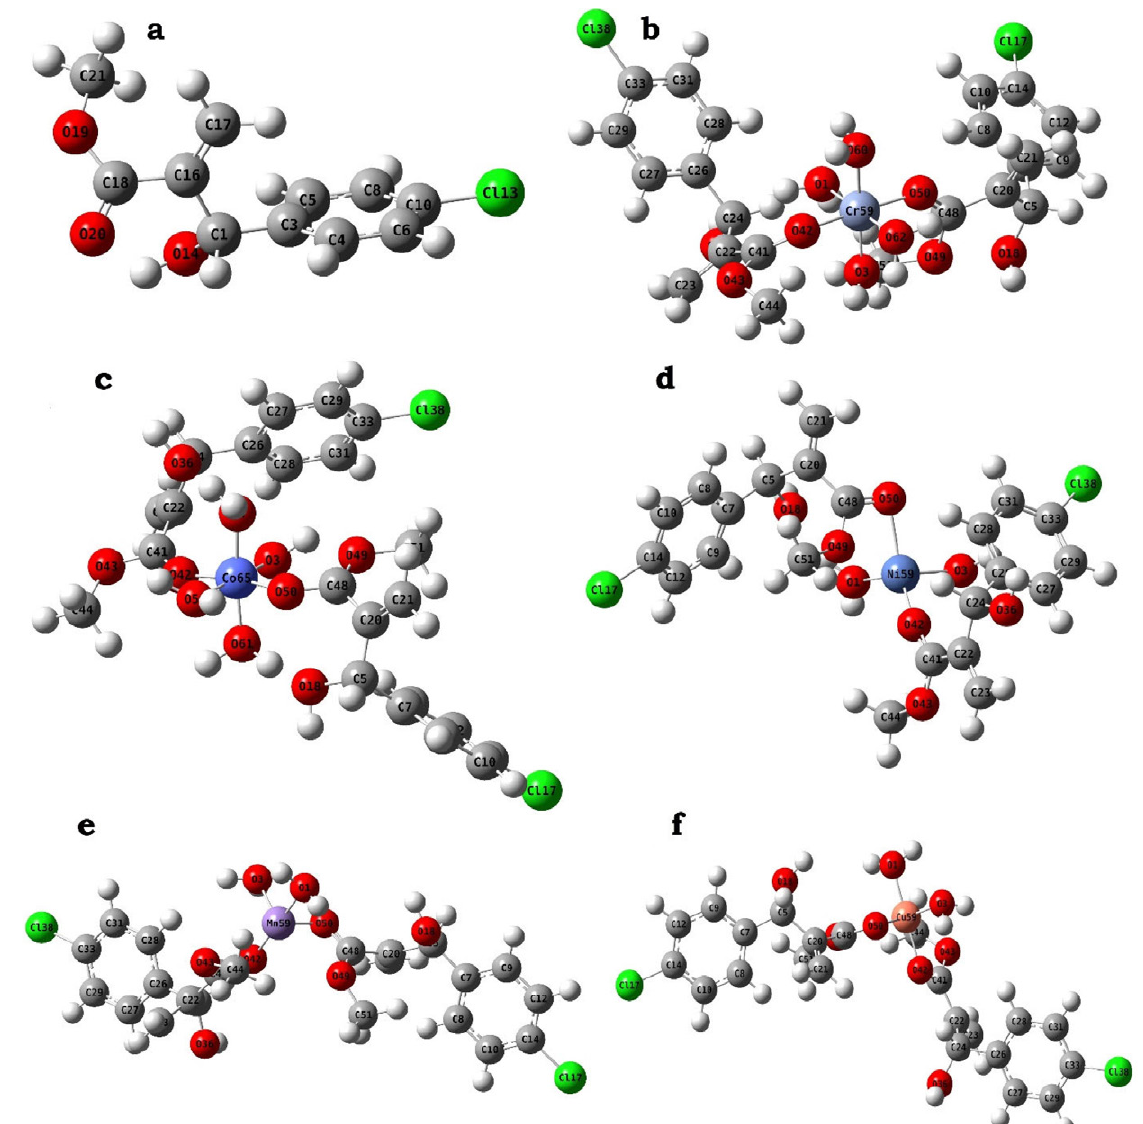
Fig. 1 . Theoretically optimized geometry of the (a) MBHA (L1), and its corresponding complexes, (b) Cr +3 L1, (c) Co +3 L1, (d) Ni +2 L1, (e) Mn +2 L1 and (f) Cu +2 L1. The results have confirmed that each metal is coordinated by two ligand molecules, Cr +3 , Co +3 are octahedral and Ni +2 , Mn +2 , Cu +2 are tetrahedral as per optimized geometrical